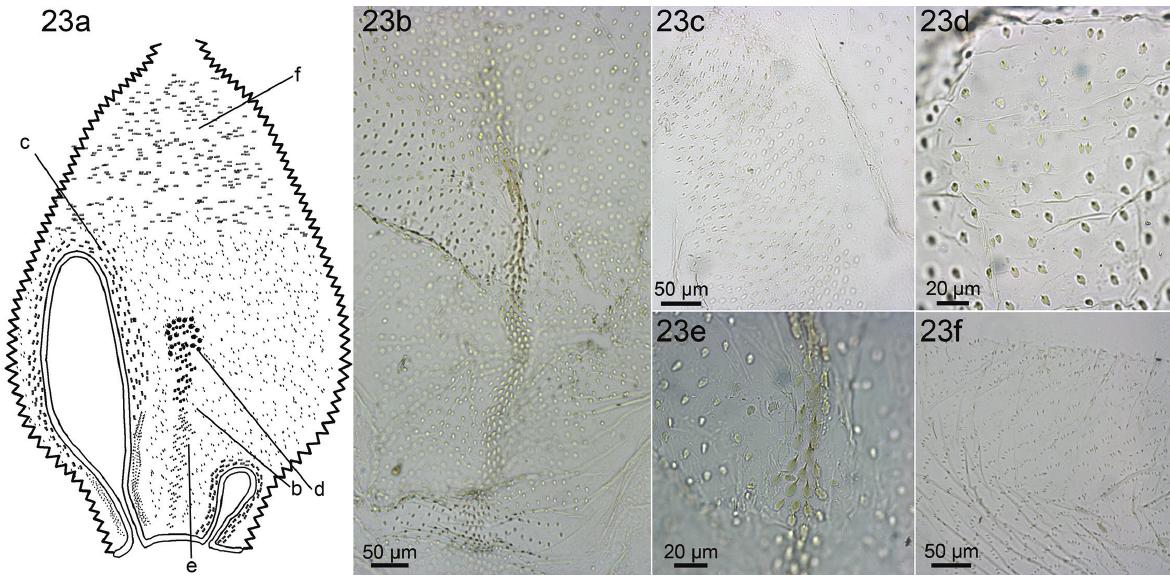
Figure 23. Syntermes molestus . (a) Schematic drawing of P1 showing arrangement of spines. (b–f) Photomicrographs: (b) General view of the region between the mesenteric tongues; (c) Detail of small spines in rows adjacent to the mesenteric tongue; (d) Detail of spines with strongly sclerotized base between the mesenteric tongues; (e) Detail of strongly sclerotized spines in the middle of the region between the mesenteric tongues; (f) Detail of the small spines in rows in the distal region.